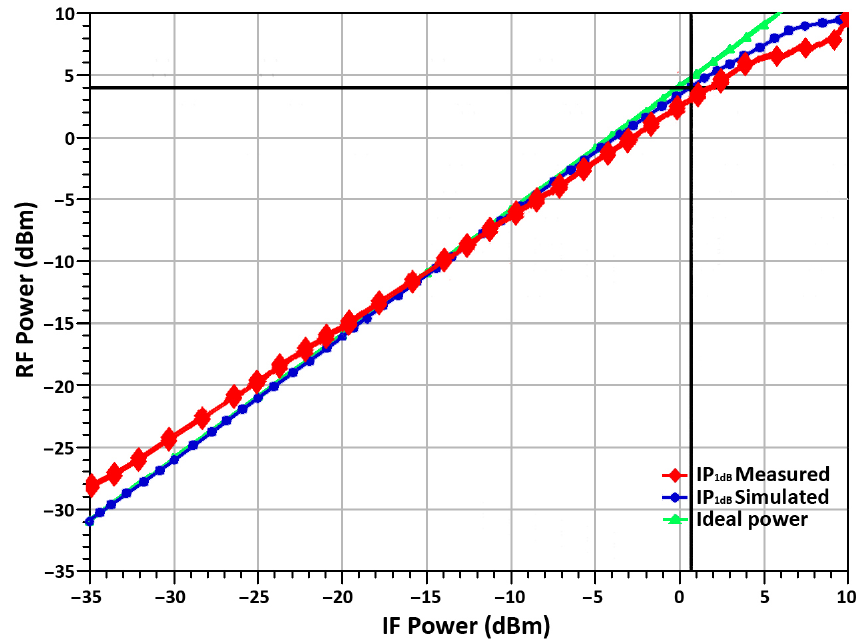
Figure 20. RF output power vs. IF input